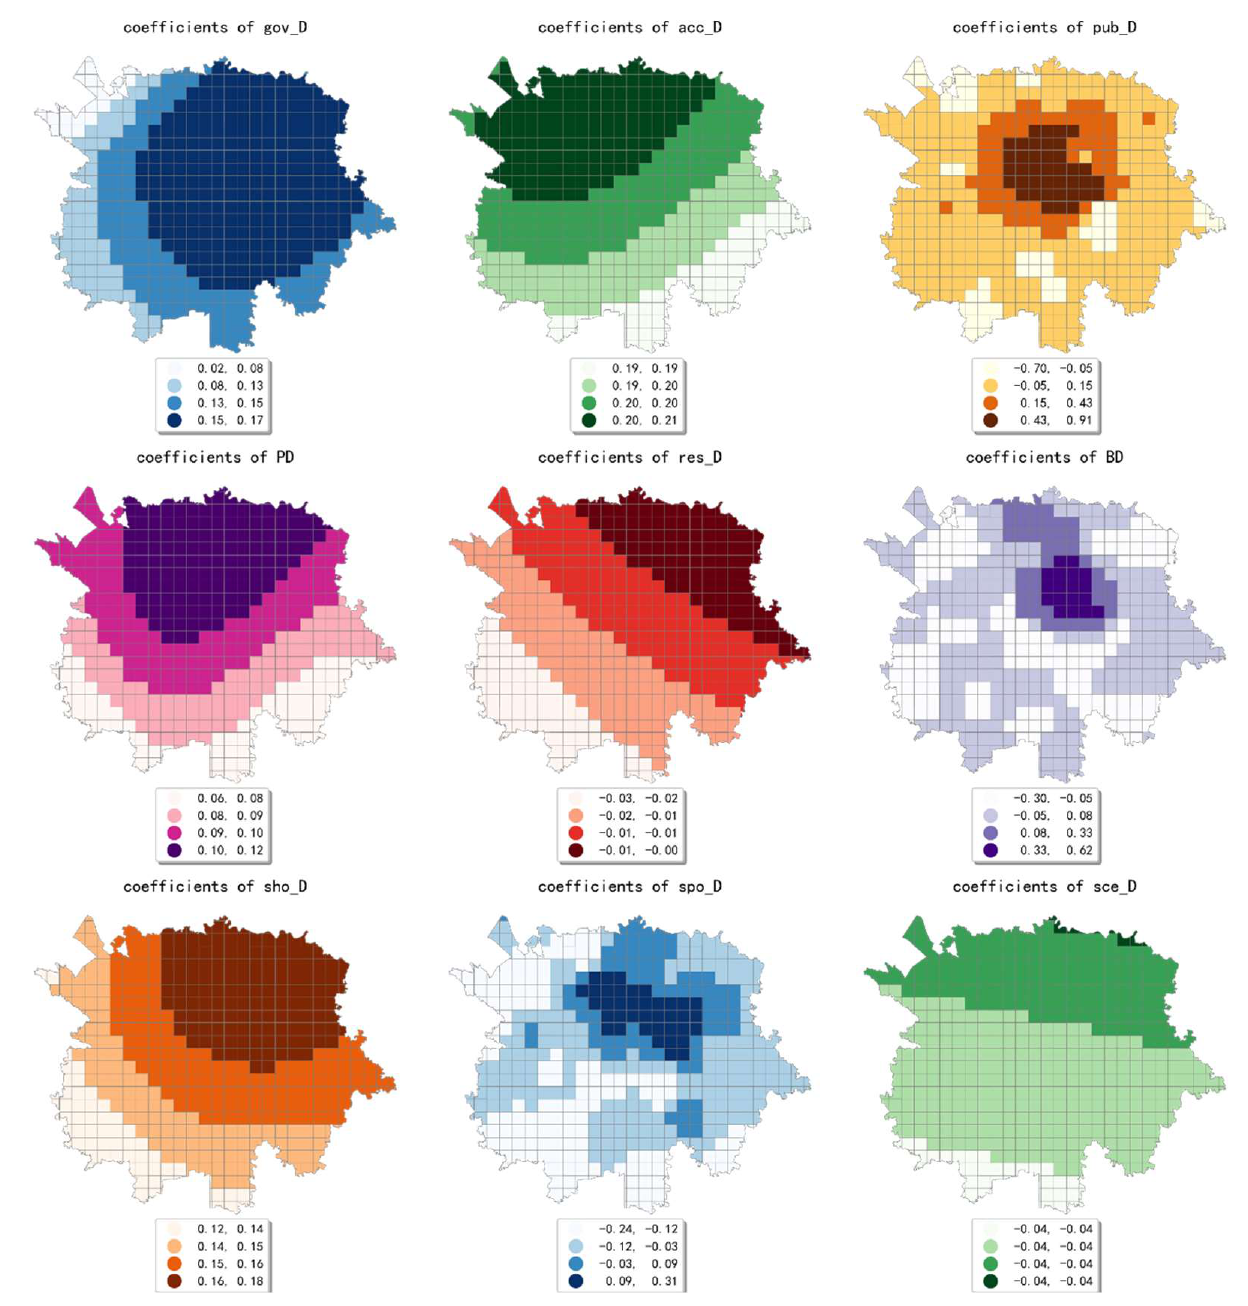
Figure 4. The estimated coefficient maps in the grid with 1500 m.